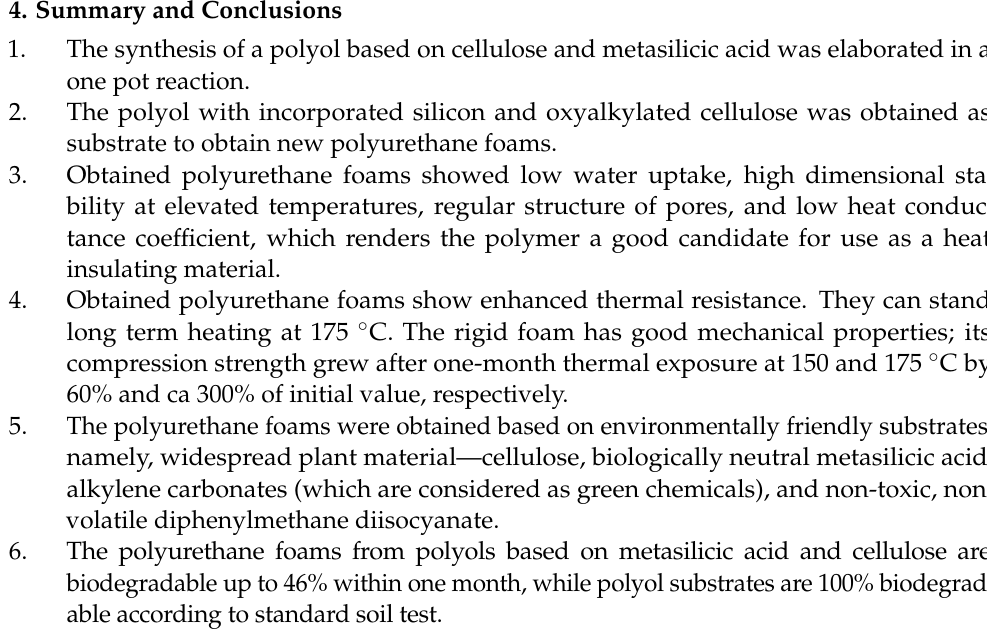
Table 12. Results of susceptibility to biodegradation of polyol and foam (BOD soil —8.5 mg/dm 3 ).